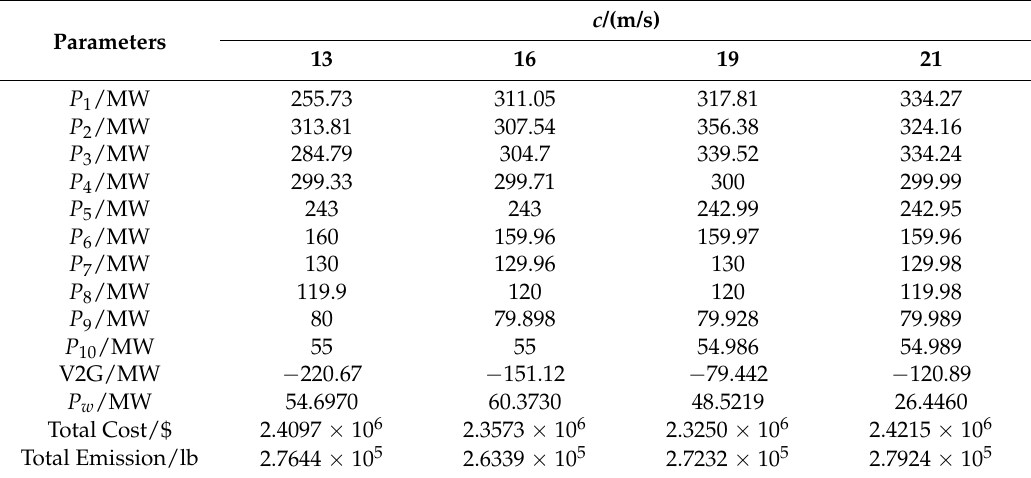
Figure 20. PFs obtained by different scale factors. Table 8. Compromise dispatching schemes obtained for different scale factors.